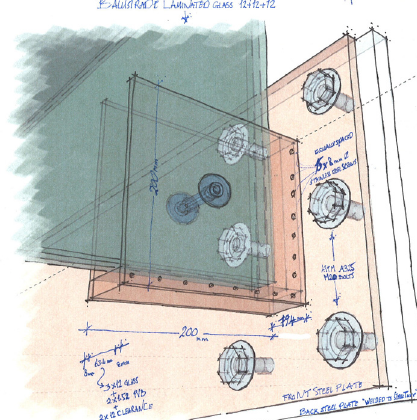
Figure 2: Steel shoe with through bolt.